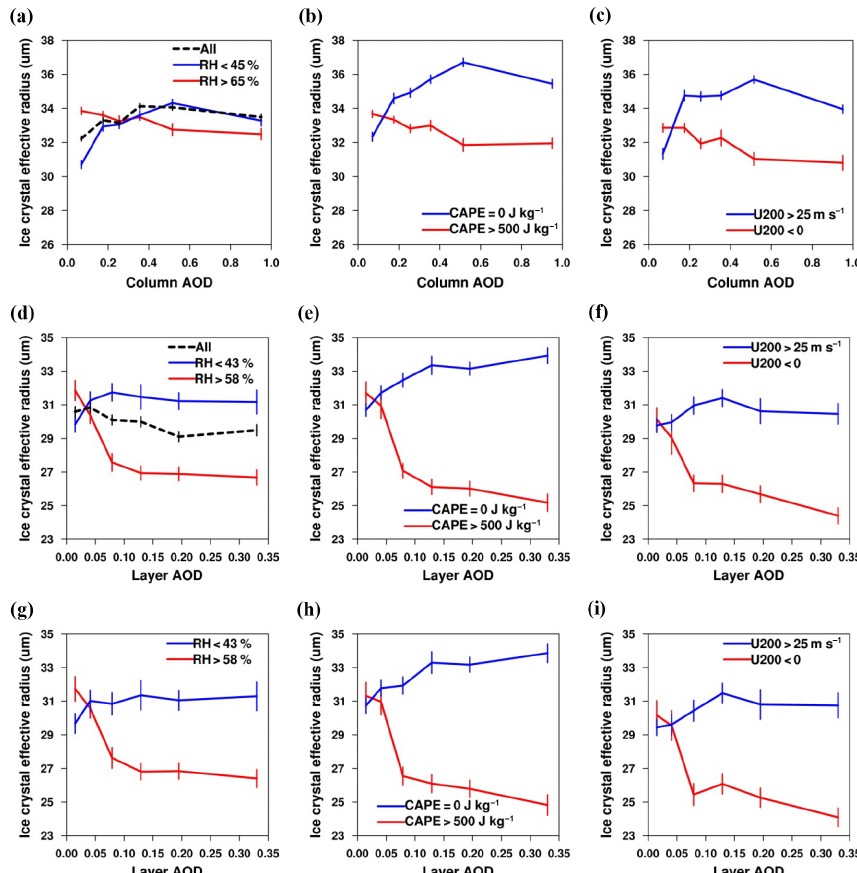
Figure 3. Changes in R ei of convection-generated and in situ ice clouds with aerosols. (a–c) Changes in R ei of convection-generated ice clouds with AOD for different ranges of (a) RH 100 − 440hPa , (b) CAPE, and (c) U200. (d–f) Changes in R ei of in situ ice clouds with layer AOD for different ranges of (d) RH 100 − 440hPa , (e) CAPE, and (f) U200. (g–i) The same as (d–f) but for the profiles with dust aerosols only. The meteorological parameters are divided into three ranges containing similar numbers of data points, and the curves for the medium range are not shown. Note that we use column AOD and layer AOD mixed with ice clouds as proxies for aerosols interacting with convection- generated and in situ ice clouds, respectively. The definition of error bars is the same as in Fig. 1. The total numbers of samples used for convection-generated and in situ ice clouds are 2 . 73 × 10 4 and 1 . 09 × 10 4 ,